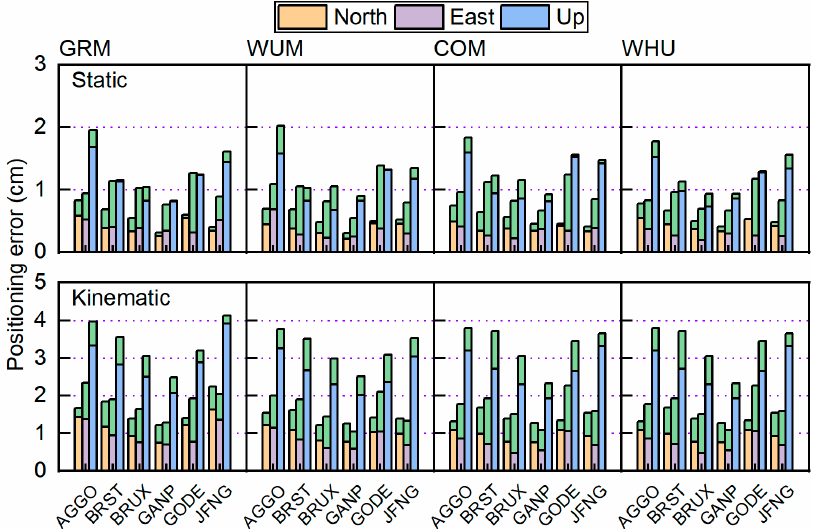
Figure 3. The positioning error of GPS-only float/fixed PPP solutions with static (top) and kinematic (bottom) mode in north, east, up components of nine days average for different stations with GRM, WUM, COM, and WHU products. The orange, purple, and blue bar denote fixed PPP solution in north, east, and up components, which plus green bar represents the corresponding float PPP solu- tion.